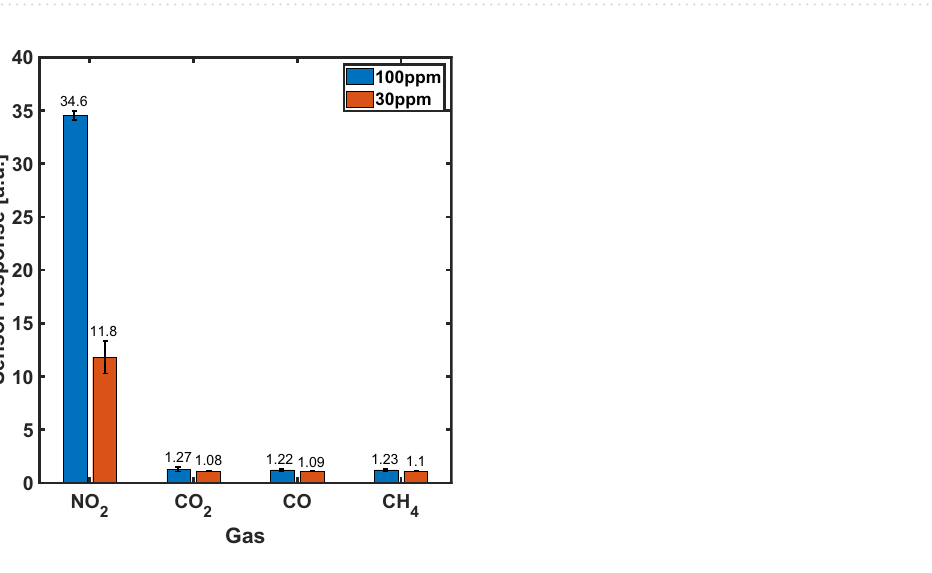
Figure 3. Selectivity of 4-layers sensors based on PbS quantum dots to 100 and 30 ppm NO 2 , CO 2 , CO, CH 4 at room